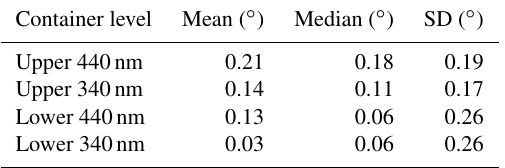
Table 4. Overview of the mean and median horizon elevations for the instruments located on the upper and lower row of containers and their corresponding standard deviations